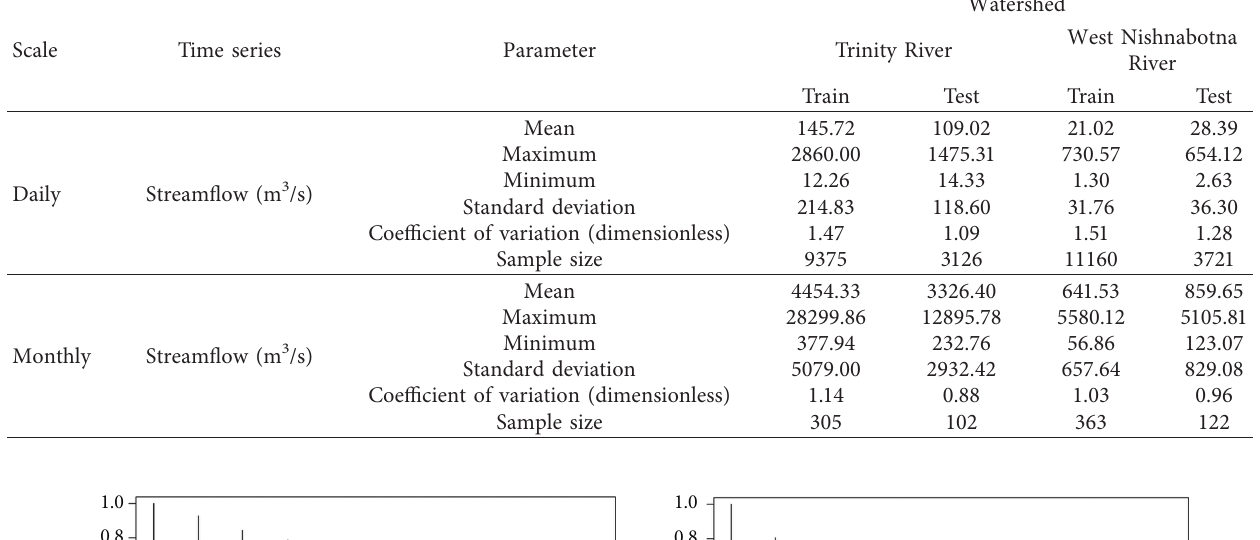
Table 1: Time series descriptive statistics.